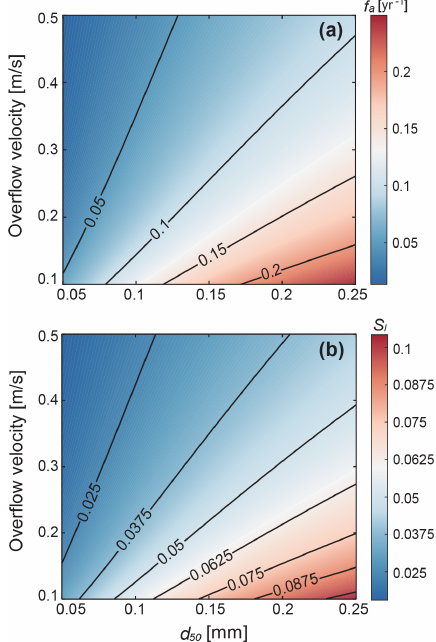
Figure 7. Modeling results for (a) avulsion frequency, f a and (b) characteristic slope of levee, S l as a function of the overflow velocity and input median grain size toward the floodplain. We set the intermittency factor, I f = 0 . 002 for all model runs.